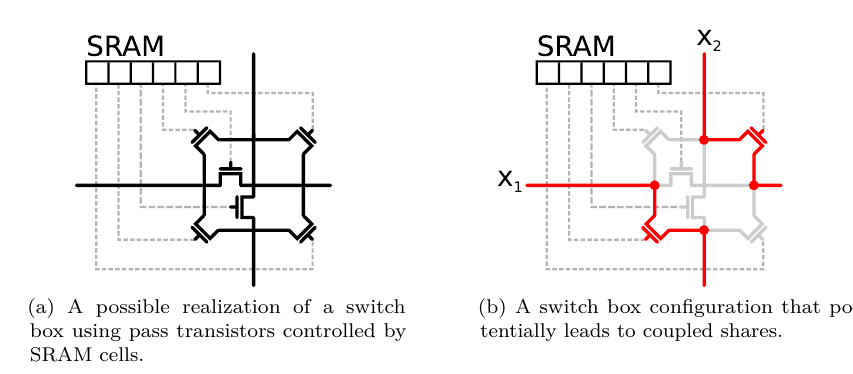
Figure 9: The routing corresponding to two shared wires can be coupled through open pass transistors in the switch box, which could fail the assumption of independent leakage between the